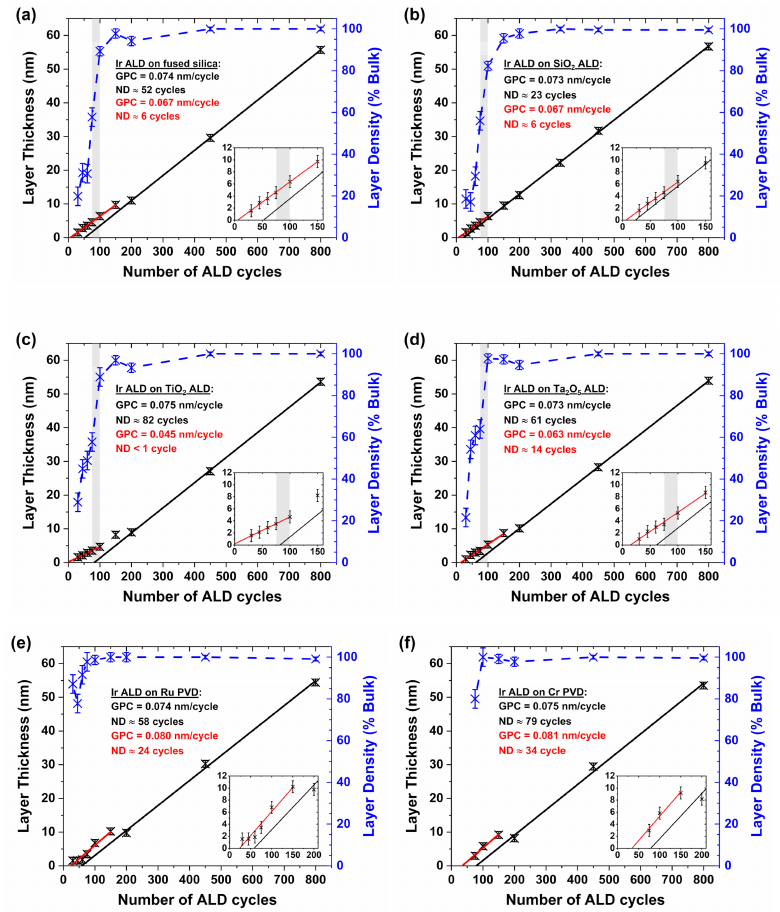
Figure 5. Layer thickness and layer density of Ir coatings depending on the number of ALD cycles on ( a ) fused silica as well as seed layers of ( b ) SiO 2 , ( c ) TiO 2 , ( d ) Ta 2 O 5 , ( e ) Ru, and ( f ) Cr. In certain regions, the film growth is fitted linear (black and red lines). The corresponding GPC and ND are indicated. A gray background highlights the region of Ir layer